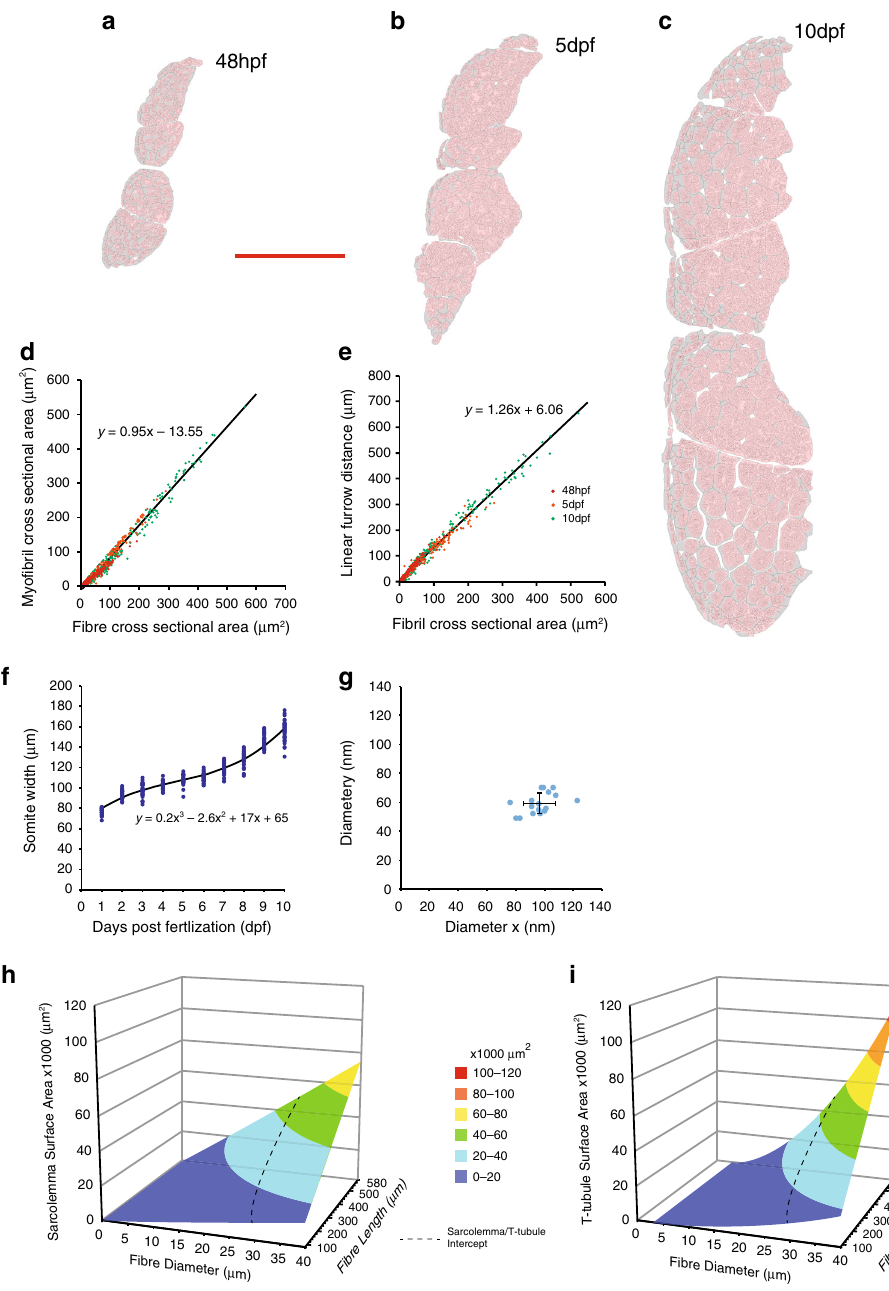
Fig. 3 Mathematical model of T-tubule development. a – c Tracing of tiled TEM montages allows extraction of quantitative data. d Relationship between fi bre cross-sectional area and myo fi bril cross-sectional area. e Relationship of myo fi bril cross-sectional area to linear furrow distance. f Somite width during the fi rst 10 days post fertilisation n > 25 per time point. g Precise measurements from focussed ion beam volumes shows that T-tubules are elliptical (see also Fig. 2j) n = 17 tubules in one fi sh. h , i Application of the model for sarcolemmal and T-tubule surface area for muscle fi bre sizes up to 40 µ m diameter× 580 µ m length. This was the maximum measured from a single 1 year old adult male. Dotted line shows the intersect of the two planes. Scale bar; ( a – c ) 50 µ